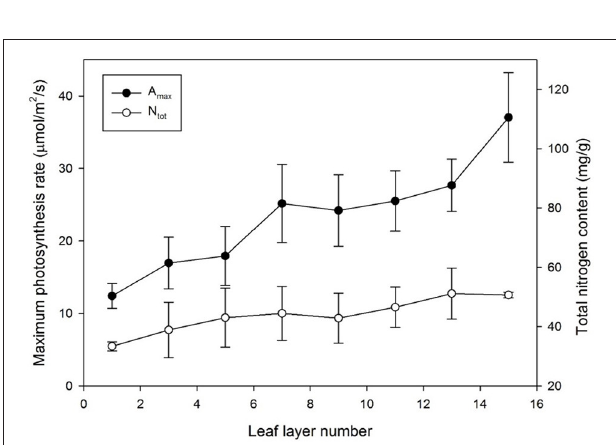
FIGURE 5 | Maximum photosynthesis rate ( A max ) and total nitrogen content ( N tot ) by leaf layer number. Vertical bars represent the Mean ± SE ( n = 5).